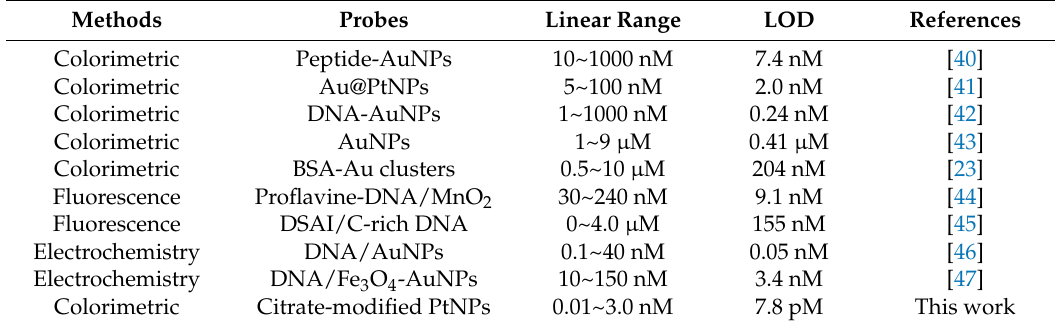
Table 2. Comparison of our present work with other methods for Ag + detection.